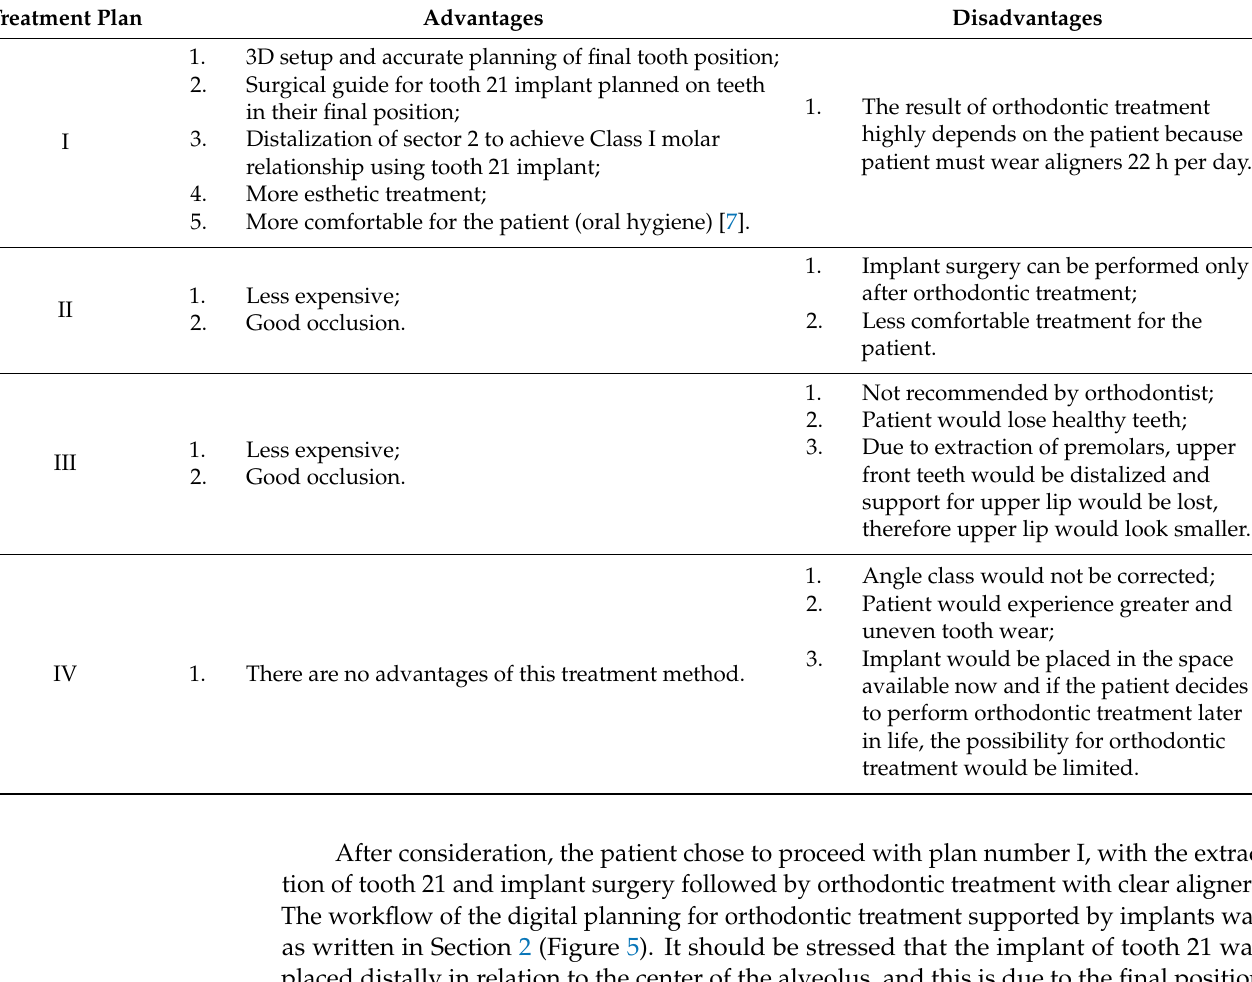
Table 1. Advantages and disadvantages of the suggested treatment plans.